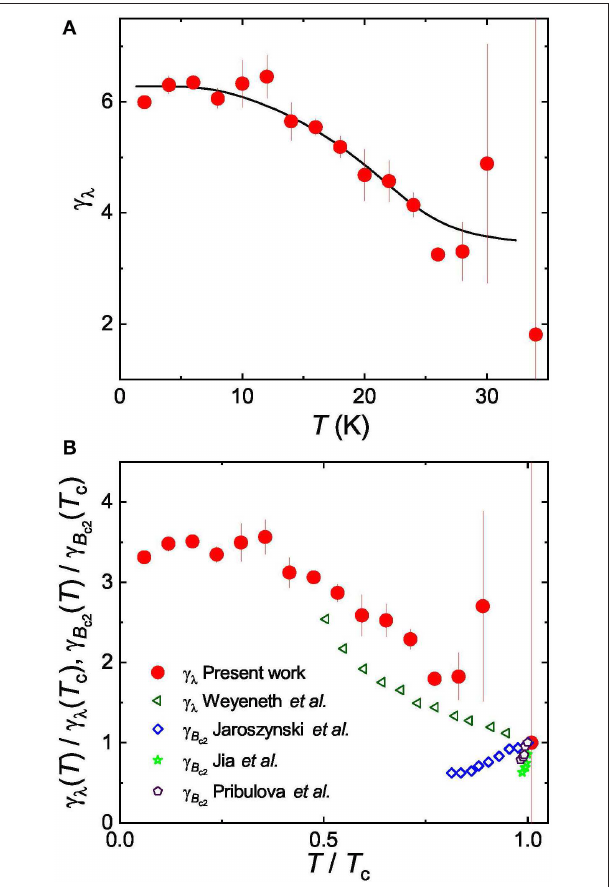
FIGURE 8 | (A) Temperature dependence of the magnetic penetration depth λ c ( T ) /λ ab ( T ). The solid curve is the result of the anisotropy, γ λ ( T ) = self-consistent two-gap model. (B) Comparison of γ λ ( T ) /γ λ ( T c ) (from the present work and reference [65]) with the anisotropy of the upper critical field γ B ( T ) /γ B ( T c ) from references [ c2 c2